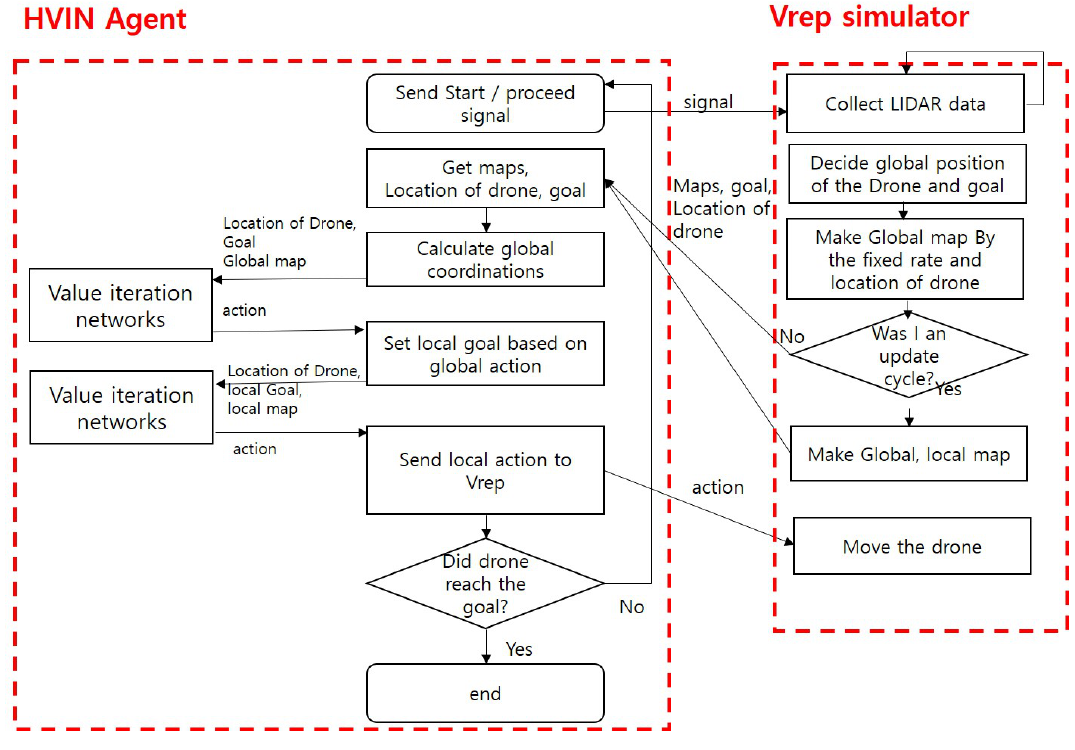
Figure 8. Procedure of Fisheye Hierarchical